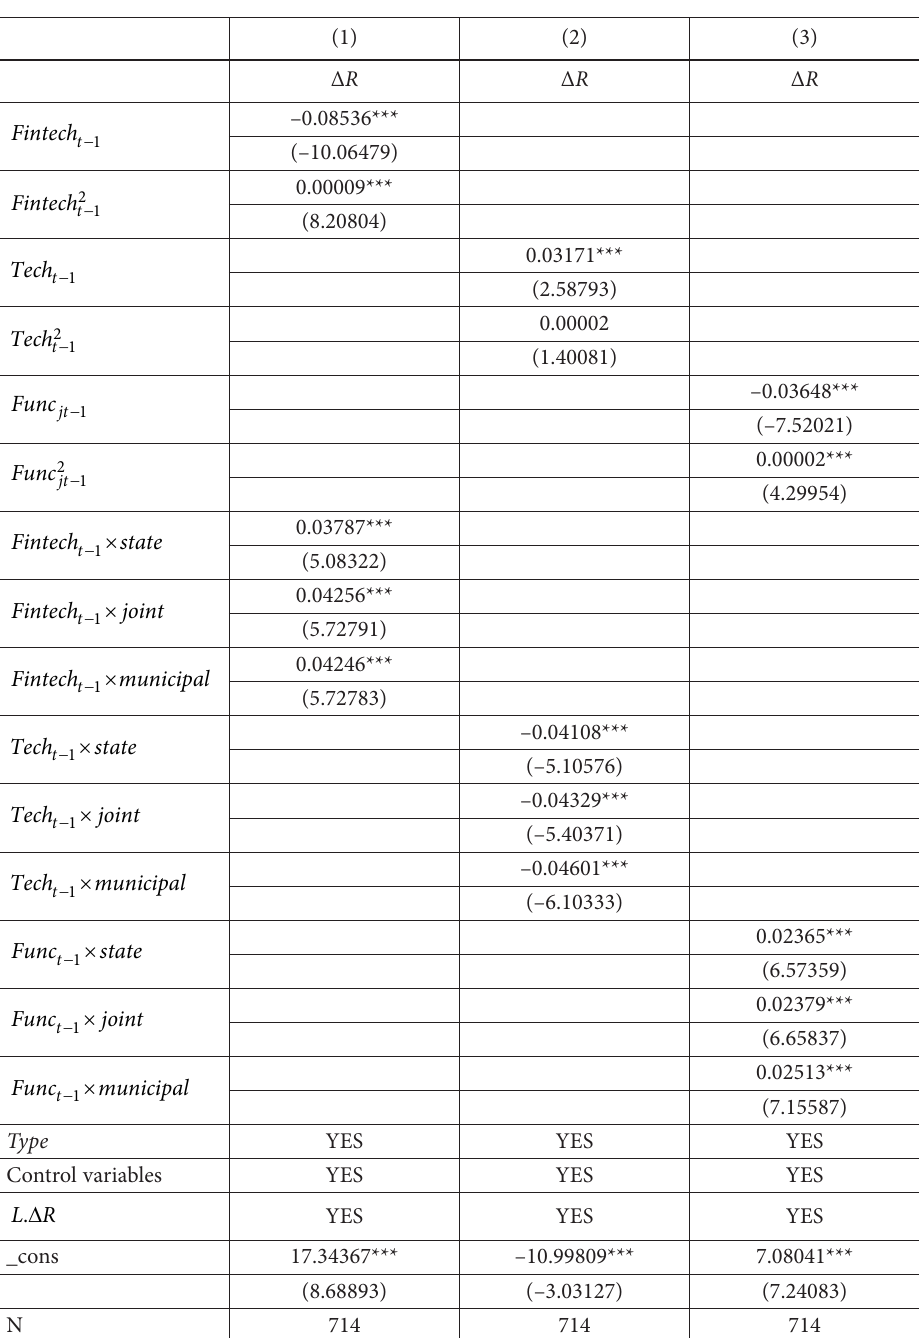
Table 4. Ownership heterogeneity of the effects of FinTech on market